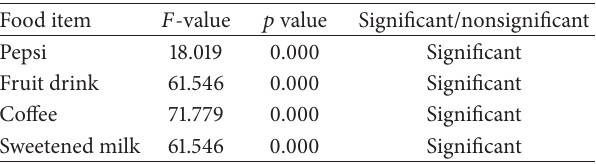
Table 4: Comparison of mean salivary pH after beverage consump- tion at different intervals of time (one-way ANOVA).